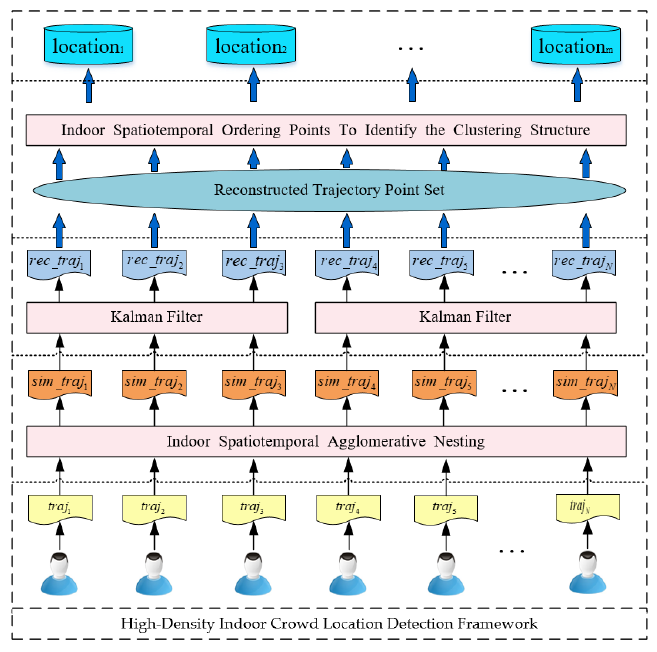
Figure 2. IndoorSRC framework.